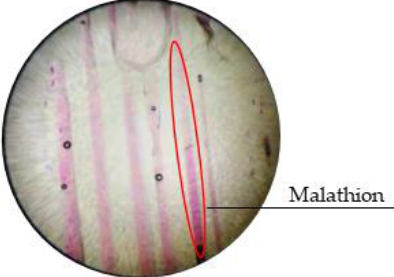
Figure 7. Pseudo-color image of malathion in pure ice.